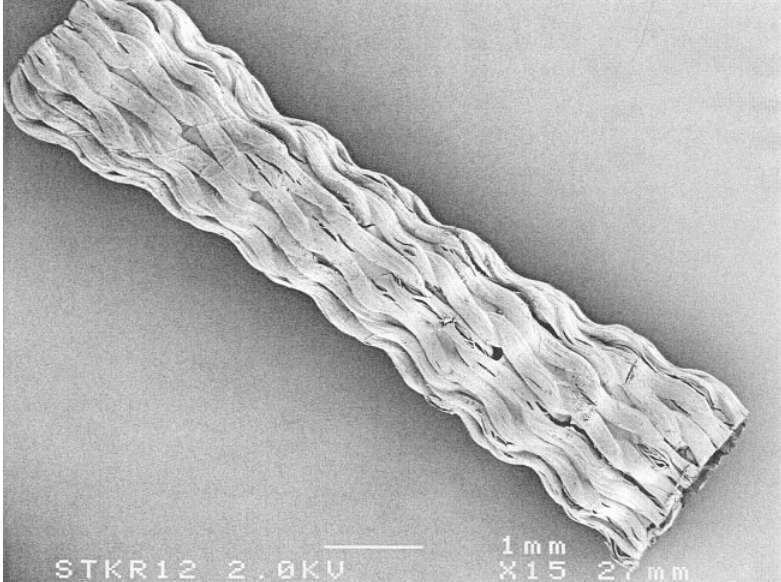
Figure 1 Scanning electron micrograph of the Hyaff11-based nerve guide. The knitted structure is clearly visible. Bar represents 1